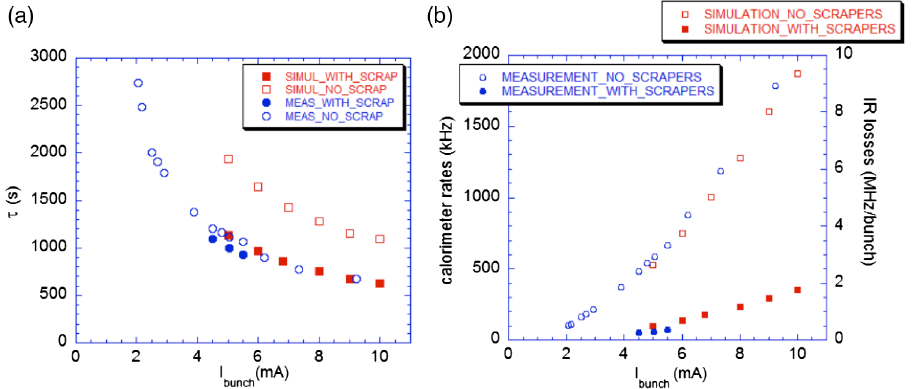
FIG. 13. Measured (blue dots) and predicted (red squares) electron beam (a) lifetime and (b) losses versus bunch current, with (cid:7) ¼ 0 : 4% .